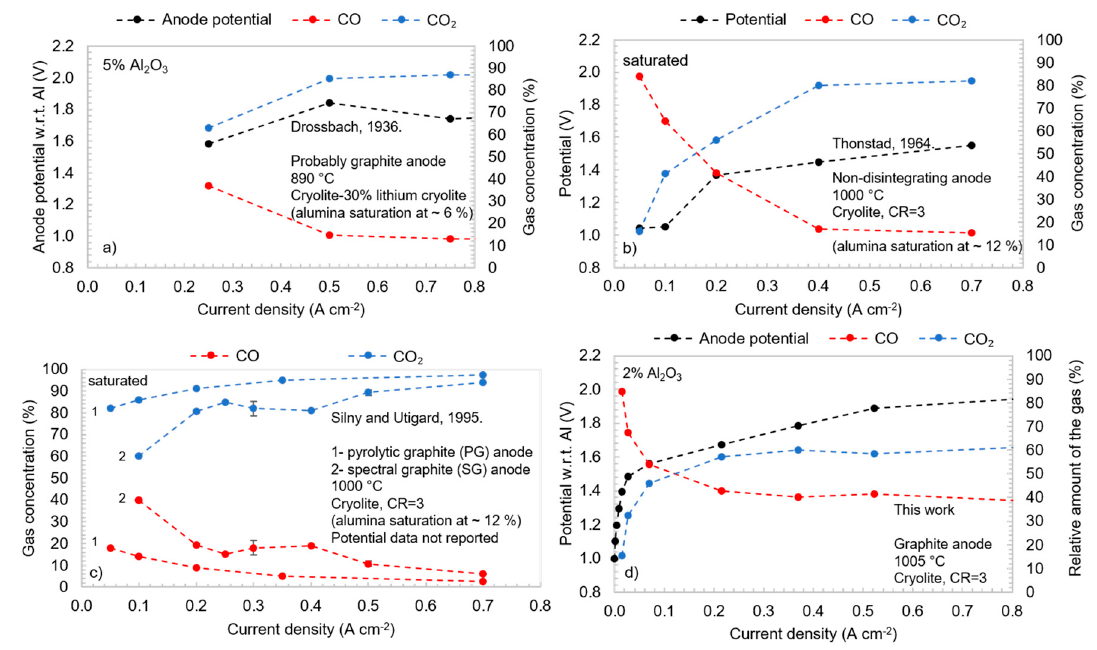
Figure 18. Anode potential and CO and CO 2 amounts versus current density. ( a ) Data extracted from Thonstad [5], ( b ) Data extracted from Drossbach [15], ( c ) Data extracted from Silny and Utigard [16], ( d ) Data from this work (rod anode).